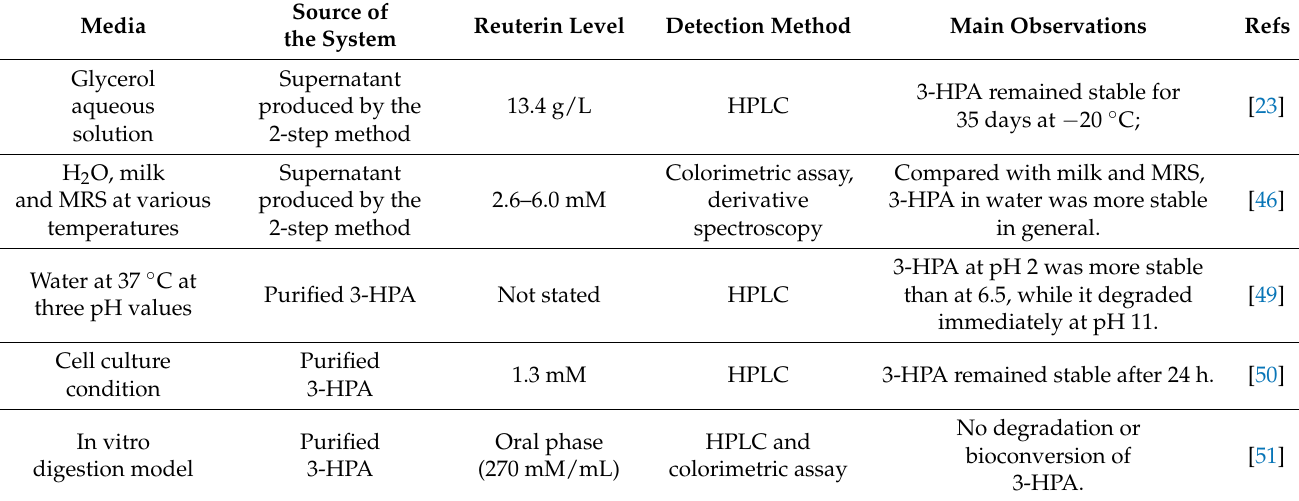
Table 1. Stability of the reuterin system under different conditions.